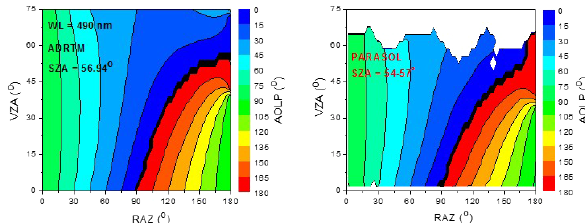
Figure 7. Comparison of the modeled AOLP of desert-reflected so- lar light with those from the PARASOL data at the wavelength of 490nm. The SZA is 56.94 ◦ in the modeling. The SZA is in the bin of 54–57 ◦ for the PARASOL